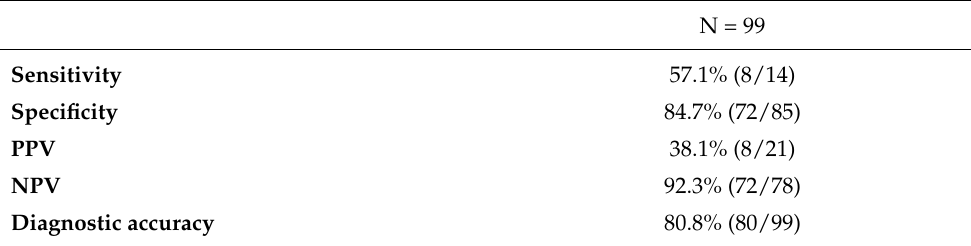
Table 3. CT scan performance in identifying SARS-CoV-2 infection. PPV=positive predictive value, NPV= negative predictive